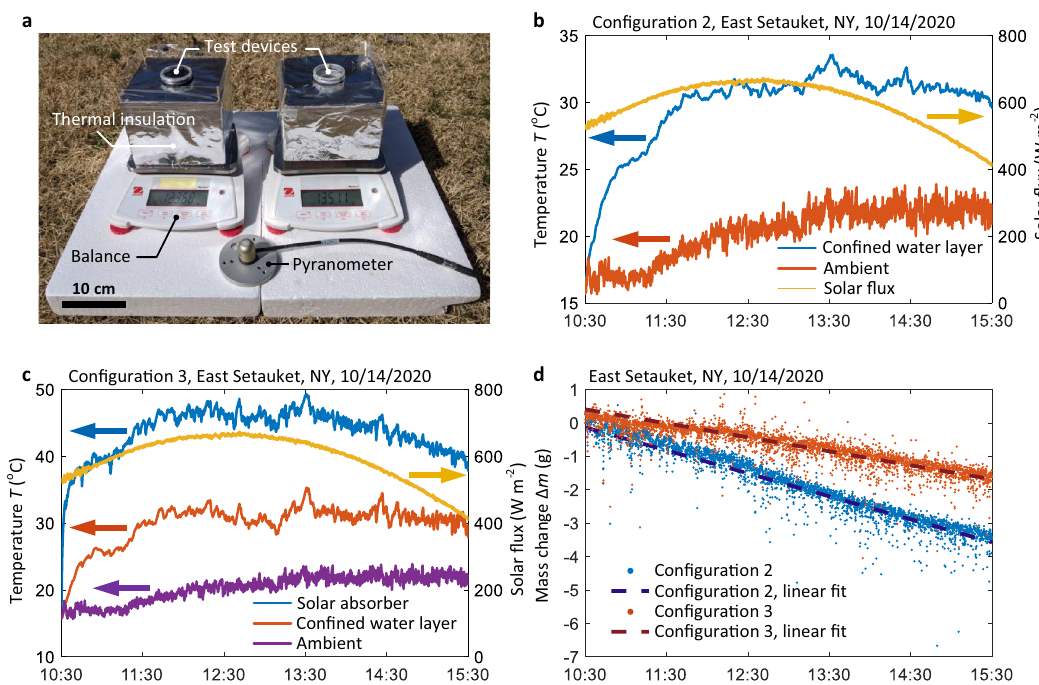
Fig. 6 Outdoor test of the con fi ned water layer structure in East Setauket, NY, USA. a Image of the experimental setup comprising of two test devices, thermal insulation, two digital balances, and a pyranometer. Two identical setups were placed next to each one, containing con fi guration 2 (the right one) and con fi guration 3 (the left one), respectively. b Real-time variations of solar fl ux, con fi ned water layer temperature (con fi guration 2), and ambient temperature during the outdoor test. c Real-time variations of solar fl ux, contactless solar absorber temperature (con fi guration 3), con fi ned water layer temperature (con fi guration 3), and ambient temperature during the outdoor test. d Real-time mass change variations of con fi gurations 2 and 3 during the outdoor test. The evaporation rates were determined from the slopes of the dashed lines using linear fi